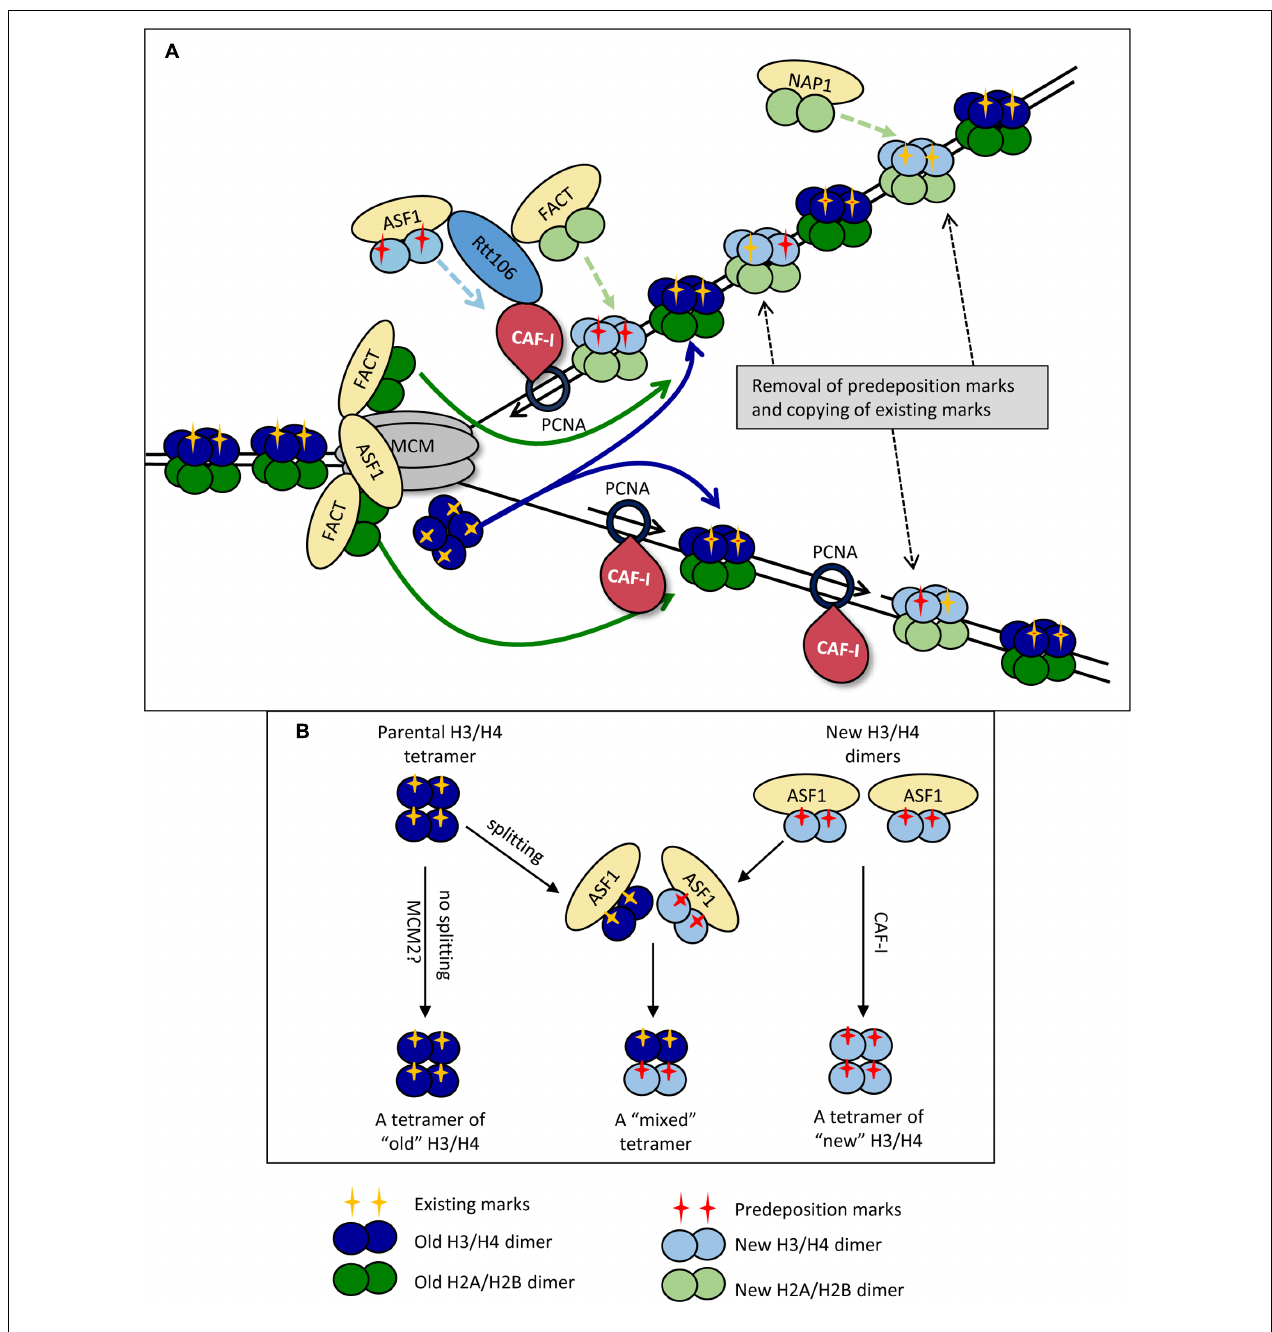
FIGURE 1 | Replication-coupled disassembly and reassembly of nucleosomes. (A) Disassembly and reassembly during elongation. FACT disassembles H2A/H2B dimers (dark green) and transports them behind the fork, where it assembles them onto the new DNA strands. FACT also transports and assembles “new” H2A/H2B dimers (light green) onto the new DNA strands. Nap1p may play a role in the assembly of new H2A/H2B behind the fork in a manner not directly coupled with the movement of the replisome. ASF1 delivers newly synthesized dimers of H3/H4 (light blue) bearing pre-deposition PTMs (red cross) to the fork. “Old” H3/H4 histones (dark blue) bearing the existing PTMs (yellow cross) are disassembled and transported behind the fork as tetramers. The ferrying of old and new histones is indicated by colored solid and broken line arrows, respectively. CAF-I associates with PCNA and assembles H3/H4 tetramers, but may also be involved in the reassembly of “old” H3/H4. “Old” and “new” H3/H4 tetramers are randomly deposited on the leading and lagging strands. Rtt106p is involved in the delivery of new H3/H4 histones, but also interacts with ASF1, CAF-I and FACT and may coordinate the assembly of H3/H4 and H2A/H2B. At varying time points after the passage of the fork, the existing he PTMs of “old” H3/H4 (yellow cross) are read by histone modifying complexes and copied onto the adjacent new H3/H4 while pre-deposition marks (red cross) are erased. (B) Dimer versus tetramer H3/H4 transfer models and the transmission of histone marks. Old H3/H4 tetramers are transferred (possibly by MCM2) and deposited onto the newly synthesized strand without splitting (Left). Newly synthesized H3/H4 dimers are delivered by ASF1 and assembled by CAF-I (Right). At certain positions of the genome or upon replication stress the old H3/H4 tetramers are split by ASF1, mixed with new H3/H4 dimers and re-assembled into mixed tetramers (center). For details see Almouzni and Cedar